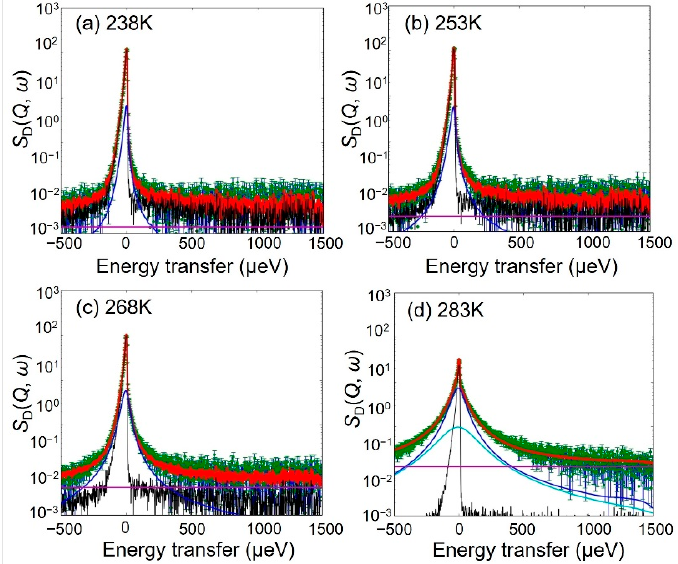
Figure 6. QENS spectra and fitted results for S H-D ( Q , ω ) with a resolution of 12 µ eV at Q = 1.0 Å − 1 and at ( a ) 238 K, ( b ) 253 K, ( c ) 268 K, and ( d ) 283 K. The green points and the red lines indicate the observed intensities and the fitted curves, respectively. The black, blue, and light blue lines represent the delta, the slow Lorentz function, and the fast Lorentz function, respectively, which are convoluted by the resolution function. The magenta line represents the flat BG.